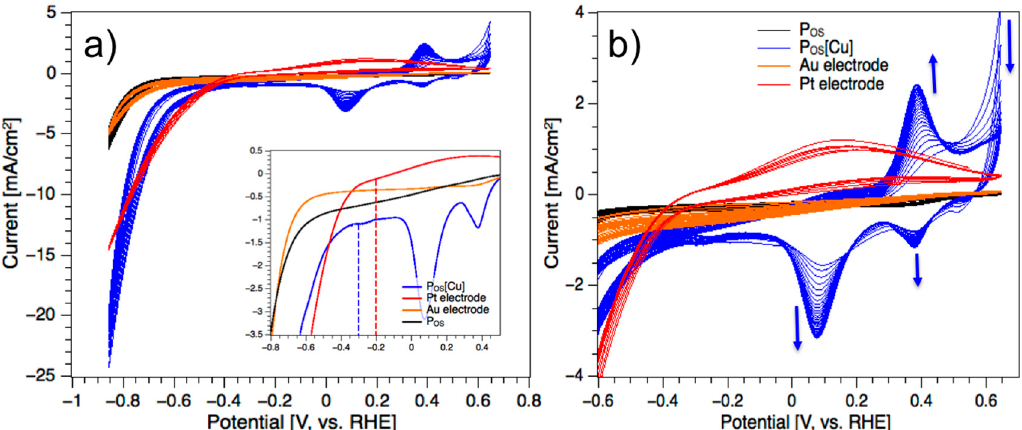
Figure 5. ( a ) Cyclic voltammogram of P OS [Cu] in 0.1 M PBS solution at a scan rate of 100 mV/s and 30 number of potentiometric sweeps compared to the polymer P OS (16 sweeps), the Au substrate (18 sweeps) and the Pt electrode (7 sweeps); ( b ) cut-out of the CV from 5a highlighting the reversible redox peaks between 100 and 400 mV vs. RHE.